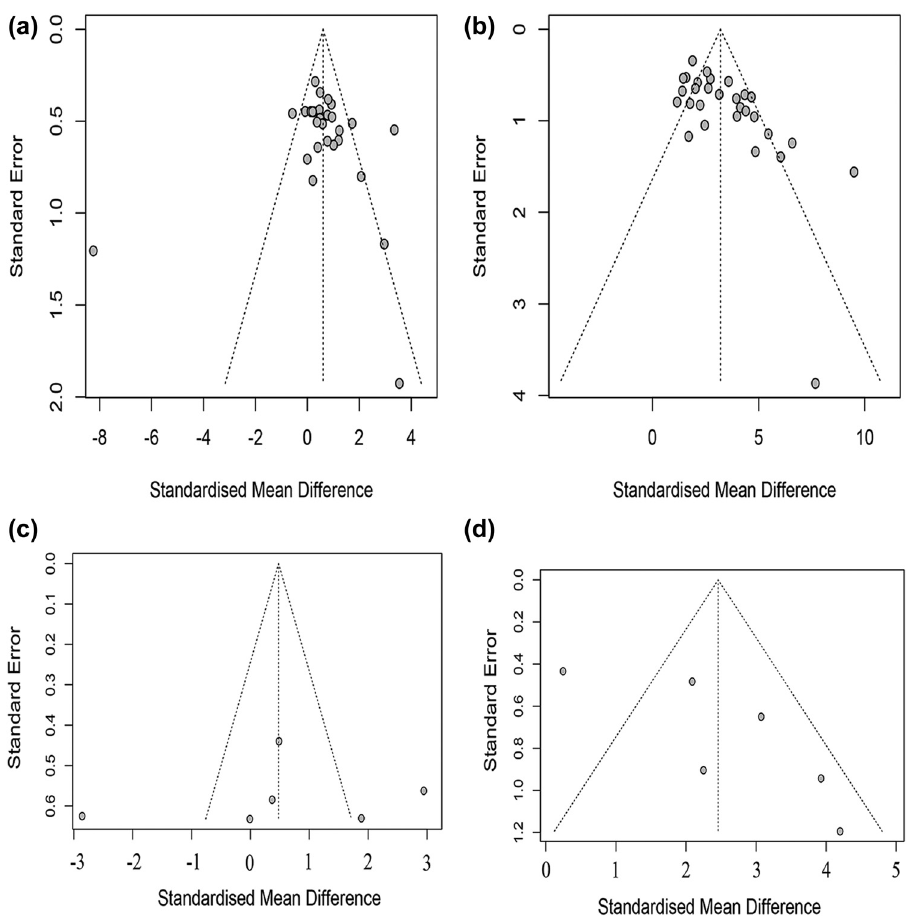
Figure S1: Funnel plots were conducted for pooled analysis of BBB at the fi rst measurement ( a ) , pooled analysis of BBB at the